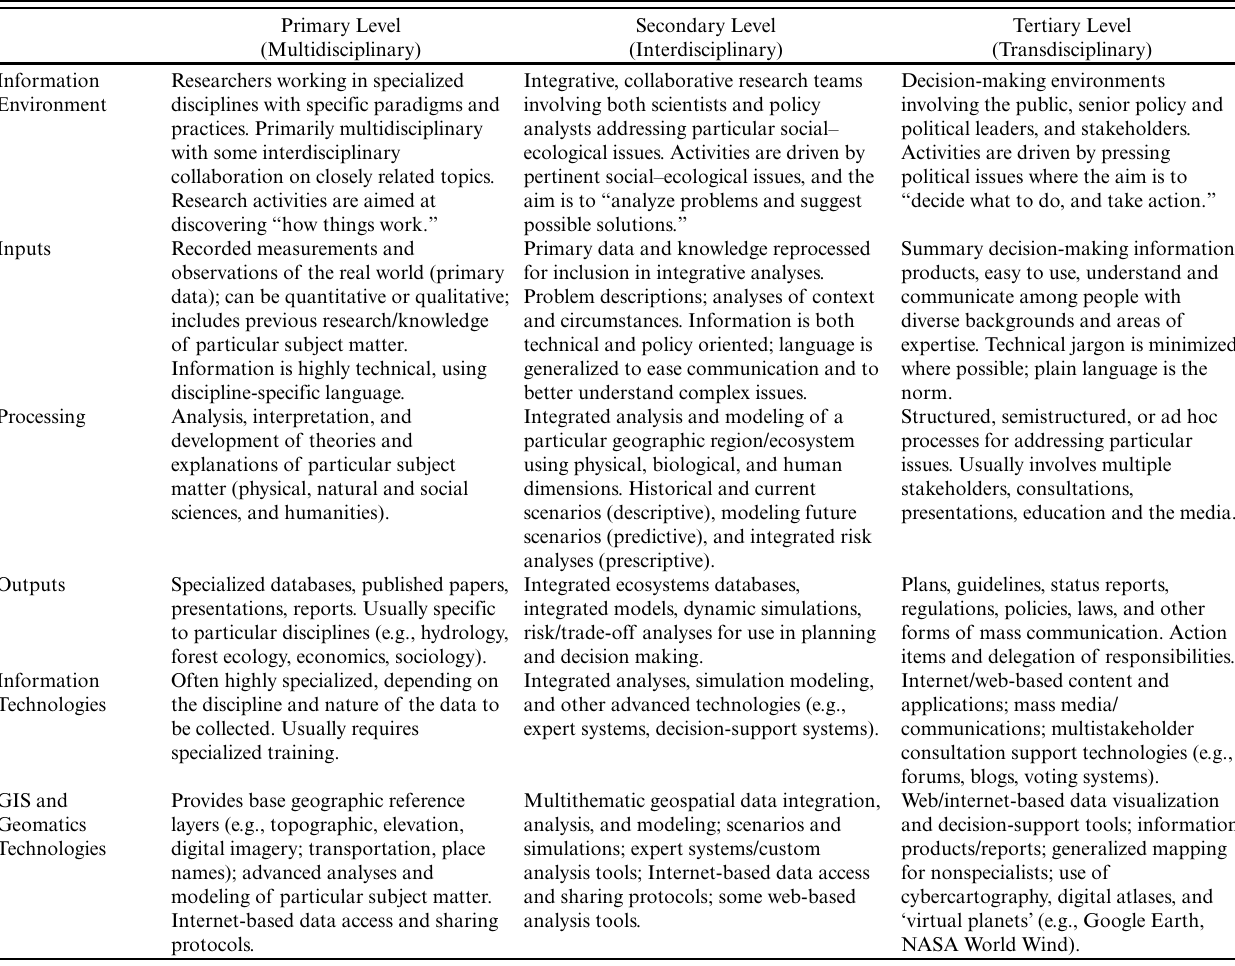
Table 1 . General characteristics of primary, secondary, and tertiary information environments; modified after Eddy and Taylor